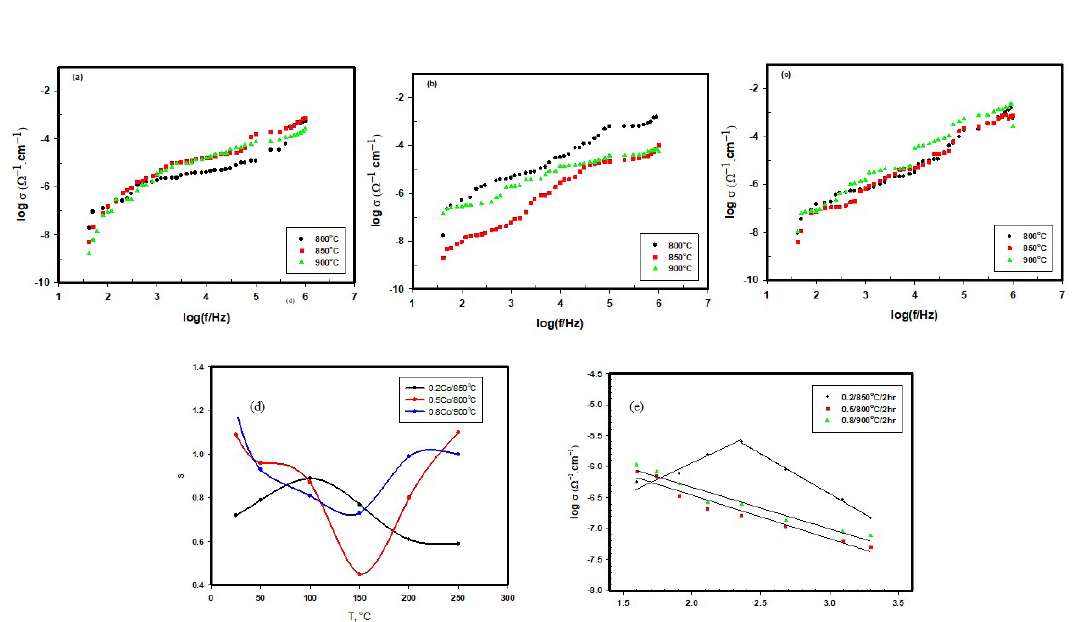
Figure 6. Variation of conductivity with frequency for Zn-ferrite with different concentration of Co ion (a) 0.2, (b) 0.5 (c) 0.8 samples prepared by solid state method and sintered at different temperature (d) The relation between frequency exponent s and the temperature (e) The relation between conductivity and the reciprocal of temperature at 100